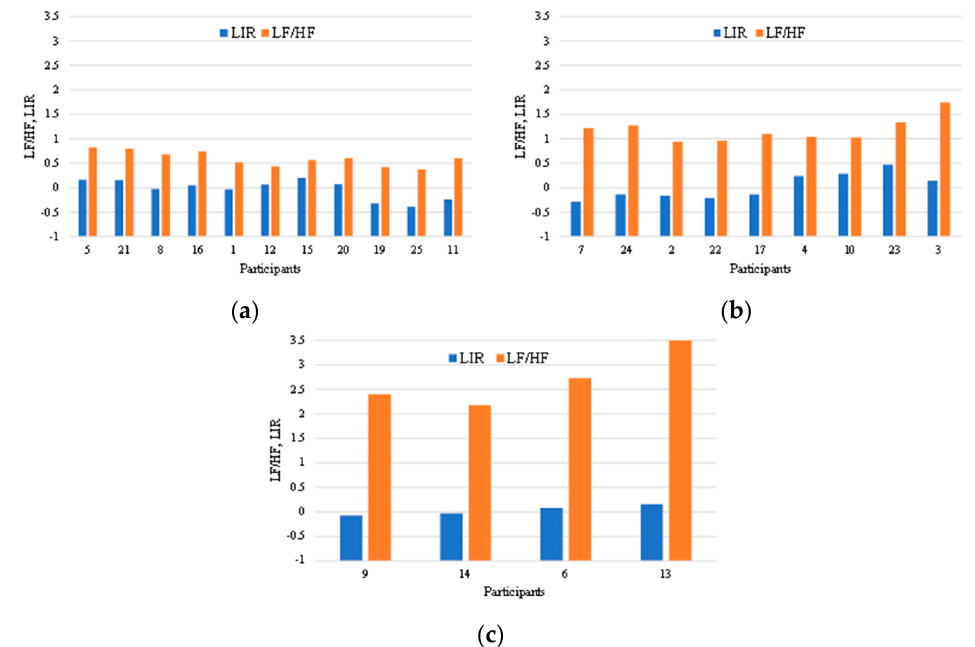
Figure 11. Cluster division based on biological information when the eyes are closed at rest. ( a ) Group A; ( b ) Group B; ( c ) Group C.